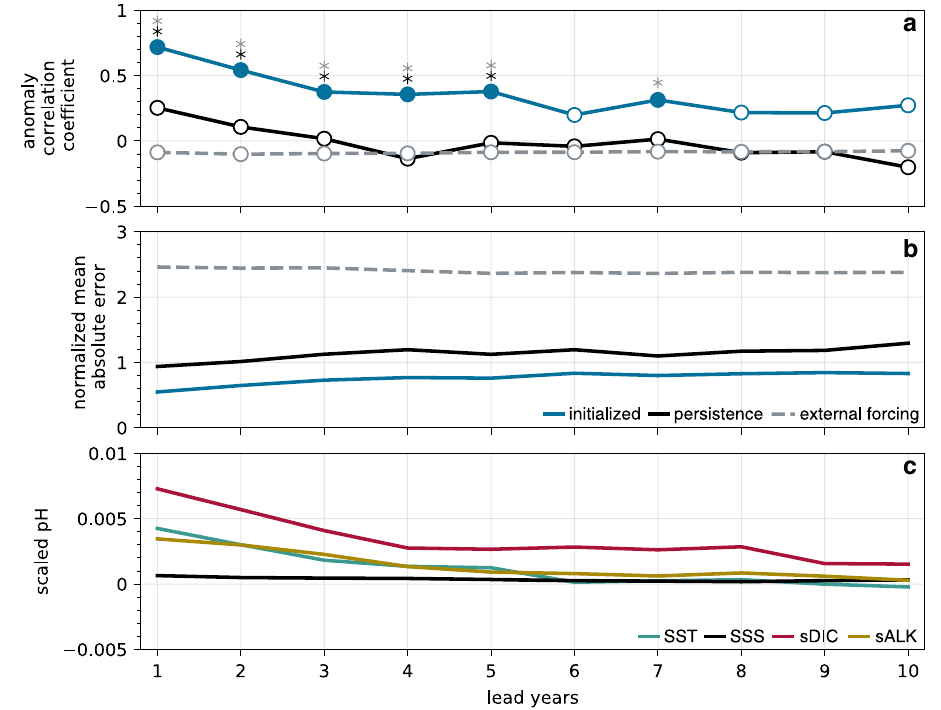
Fig. 4 Domain-wide potential predictability of surface pH anomalies. a Anomaly correlation coef fi cients (ACCs) for 10 lead years for (blue) the Community Earth System Decadal Prediction Large Ensemble (CESM-DPLE), (black) a persistence forecast from the reconstruction, and (gray) the uninitialized CESM Large Ensemble (CESM-LE) ensemble mean. Filled circles denote statistically signi fi cant positive correlations at the 95% level using a t test. An effective sample size is used in the t test to account for autocorrelation in the two time series being correlated. The critical value required for a statistically signi fi cant correlation ranges from 0.26 to 0.32 across leads, as computed by inverting the t statistic formula. Black and gray asterisks indicate signi fi cant predictability over persistence and the uninitialized forecast at the 95% level using a z test, respectively. b As in a , but for normalized mean absolute error (NMAE) and without signi fi cance testing. Values below (above) one indicate that the forecast falls within (outside of) the interannual variability of surface pH in the reconstruction. c Scaled predictability in common pH units (see Linear Decomposition in Methods) of (black) sea surface salinity (SSS), (teal) sea surface temperature (SST), (gold) salinity-normalized alkalinity (sALK), and (red) salinity-normalized dissolved inorganic carbon